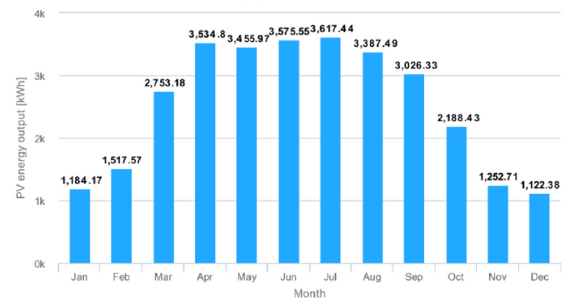
Figure 13. Monthly PV production—Case 2.